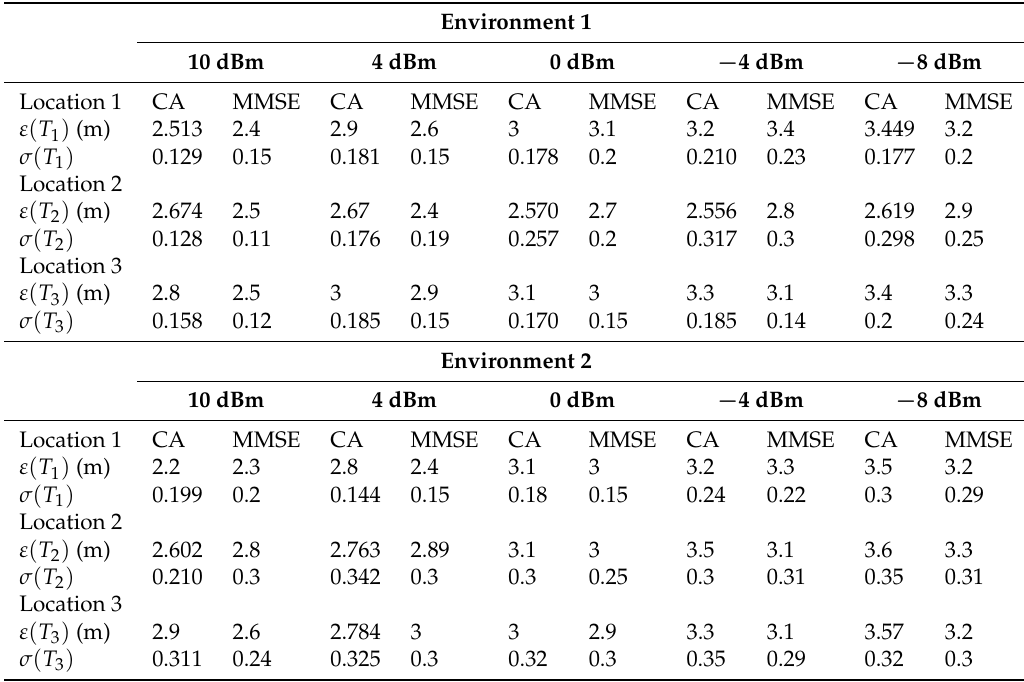
Table 7. Localization Accuracy and Localization Precision by using LPF at 3 Tag Locations in Environment 1 and Environment 2.